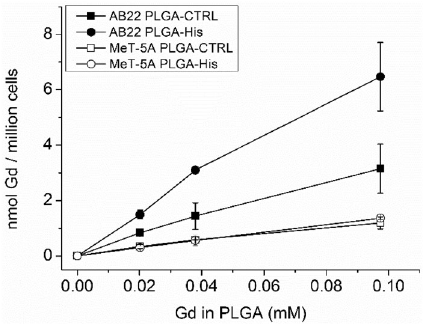
Figure 2. Uptake study performed incubating increasing Gd concentration in PLGA-CTRL and PLGA-His on AB22 and MeT-5A for 24 h at 37 °C, 5% CO 2 .